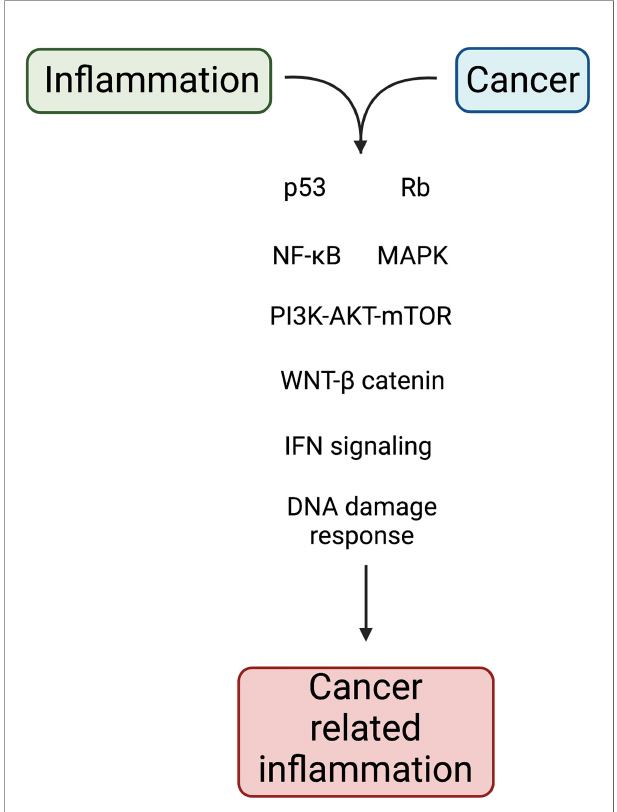
FIGURE 2 | Molecular pathways linking in fl ammation and cancer. Chronic in fl ammation acts as an extrinsic pathway for cancer development. In tissue cells, genetic and epigenetic alterations act as intrinsic pathway to induce cell transformation. Both pathways impact on the activation of transcription factors that support in fl ammation and tumorigenesis. Created with